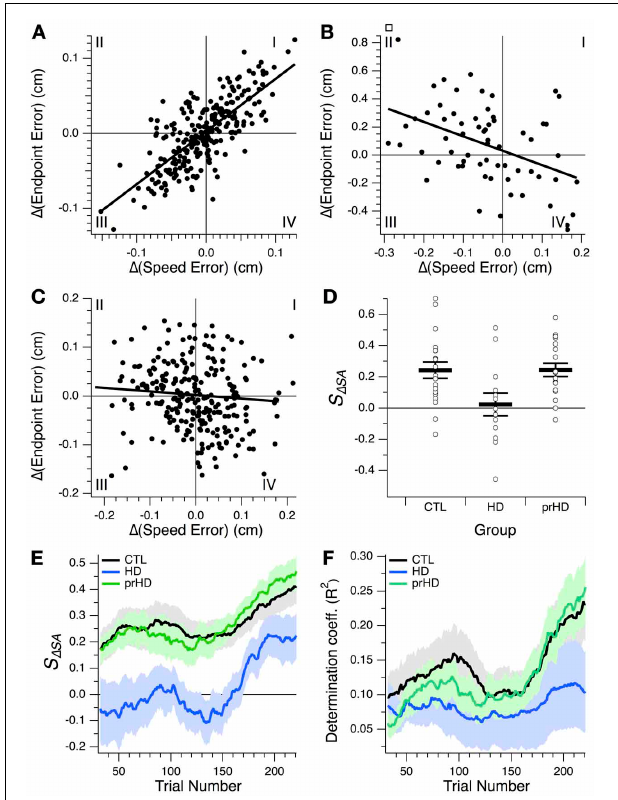
FIGURE 7 | Relationship between changes in speed and accuracy across trials. (A–C) Trial-by-trial changes in endpoint error vs. changes in speed error for a CTL subject (A) and two HD subjects (B,C) . Linear regression lines are also shown. All 256 trials from the learning session are shown in (A,C) ; the first 64 trials are shown in (B) . Roman numerals indicate standard numbering of quadrants in x-y plots. (D) Speed-accuracy-change slope, S (cid:2) SA , for the three subject groups studied. This slope is the slope of the linear correlation between endpoint error changes and speed error changes, as illustrated in (A–C) . Horizontal bars indicate group mean ± SE. Open circles indicate individual subjects’ slopes. (E,F) Progression of speed-accuracy-change slope, S (cid:2) SA , and coefficient of determination, R 2 , for the linear correlation between trial-by-trial endpoint error change, (cid:2)( EndpointError ) , and speed error change, (cid:2)( SpeedError ) . These correlations were calculated, for each trial, based on a 64-trial window around that trial, which yielded values for trials 32–224 of the 256-trial learning session. Traces indicate group means (black, CTL; blue, HD; green, prHD). Shading denotes standard